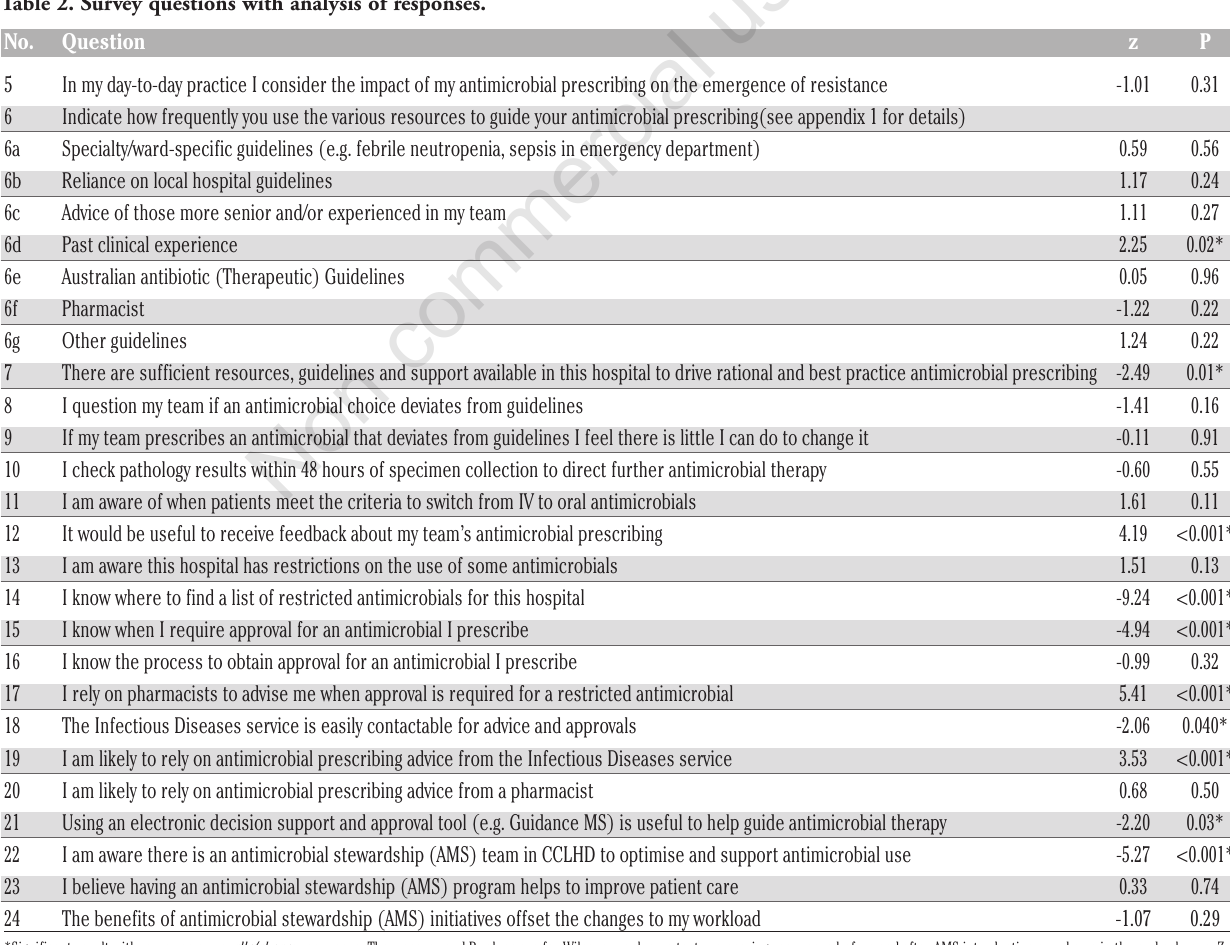
Table 2. Survey questions with analysis of responses.